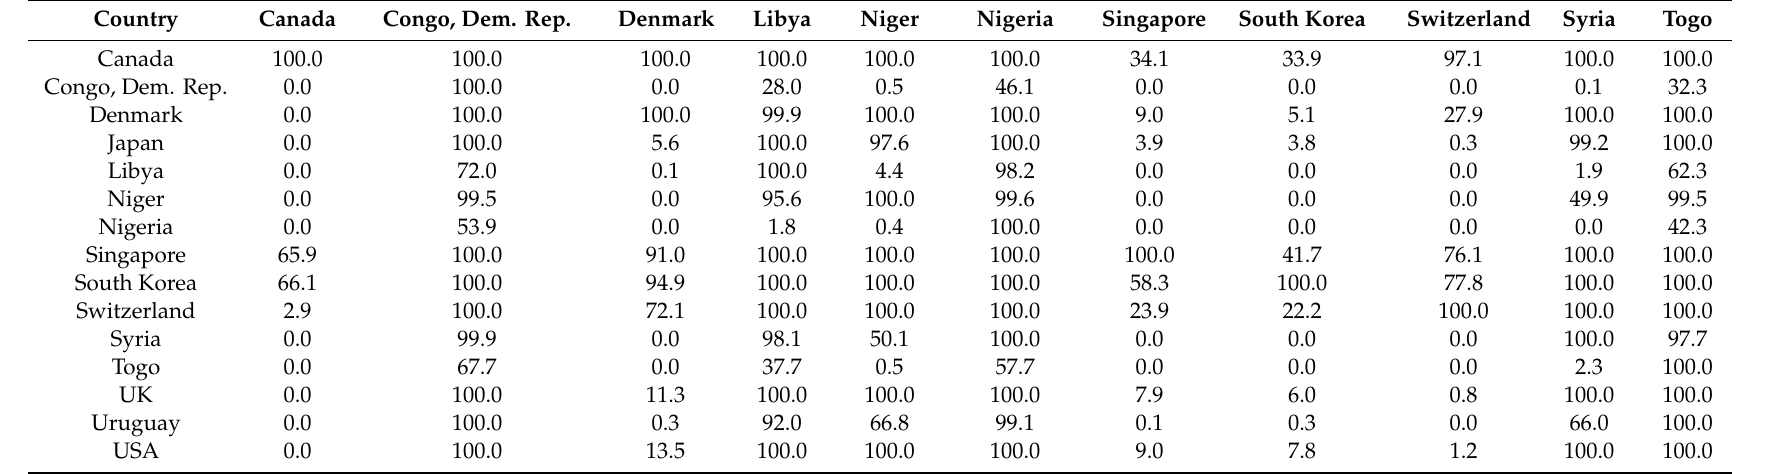
Table 11. Pairwise e ffi ciency outranking indices (PEOI) for selected pairs of countries. The values indicate the shares (in percentage) of weight vector samples for which a country has an e ffi ciency score not worse than another (i.e., at least as good). Due to the large number of countries in the data set, the complete table is available in the ESI, Table S8. Countries hereby shown include the best- and worst-performing ones, ties and some of the ones discussed in this paper.